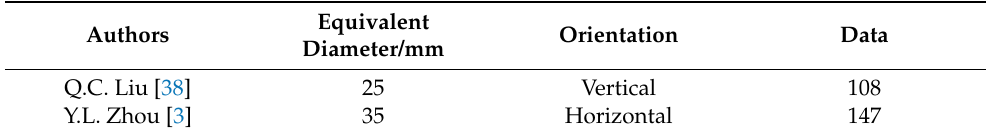
Table 5. Pressure drop data included in the